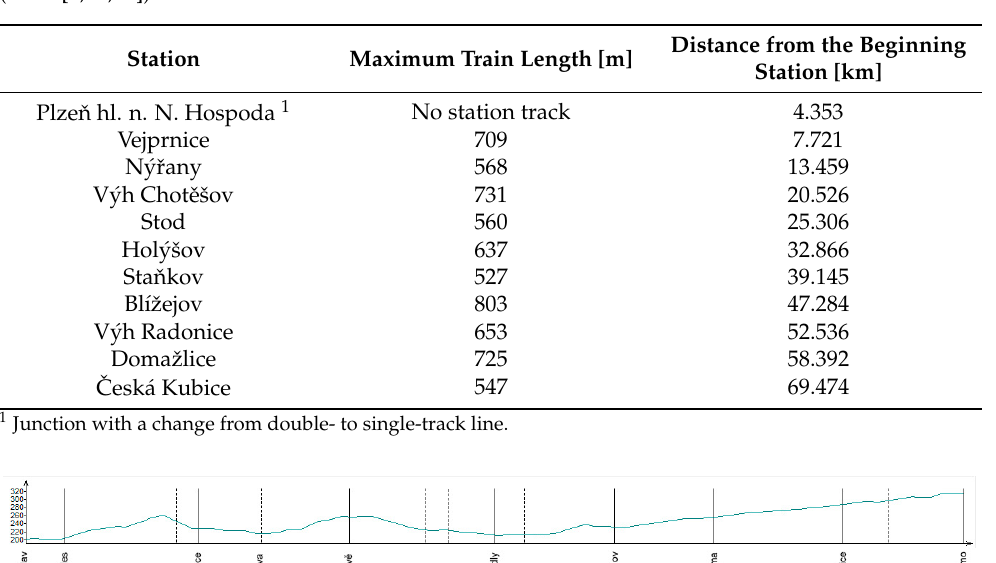
Figure 1. Longitudinal profile of the rail line 180 (data: [1,26]). Source: Authors. Table 1. Intermediate stations of the single-track line 180 Plze ň –Domažlice–Furth im Wald. (data: Table 1. Intermediate stations of the single-track line 180 Plzeˇn–Domažlice–Furth im Wald. (data: [1,23,26]). Source: Authors.